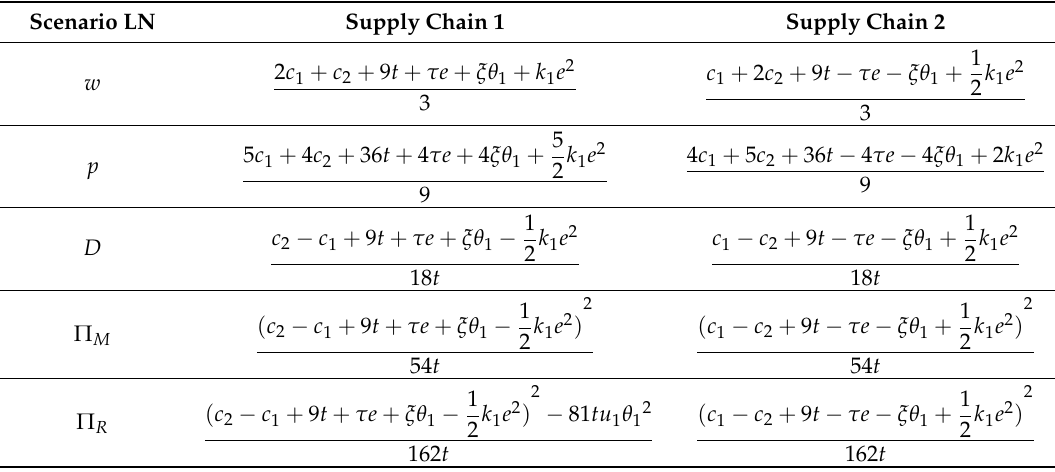
Table A3. Equilibrium outcomes under scenario